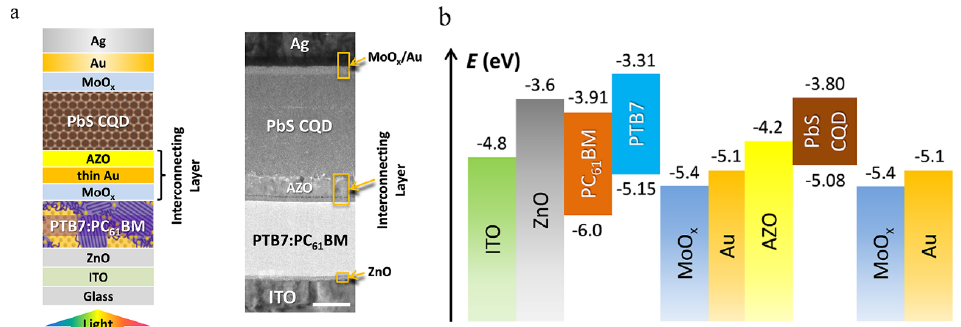
Figure 8. ( a ) Hybrid tandem solar cell configuration and TEM cross-sectional image of the corresponding Figure 8. (a) Hybrid tandem solar cell configuration and TEM cross ‐ sectional image of the device. The scale bar is 100 nm. ( b ) Energy level diagram of the hybrid tandem solar cell. Reproduced corresponding device. The scale bar is 100 nm. (b) Energy level diagram of the hybrid with permission from [85], Copyright © 2018, American Chemical tandem solar cell. Reproduced with permission from [85], Copyright © 2018, American Chemical Society.